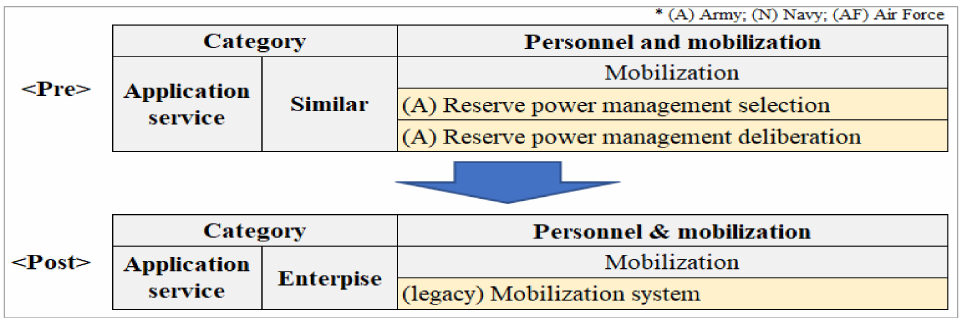
Figure 12. Integrating similar services into legacy enterprise service .